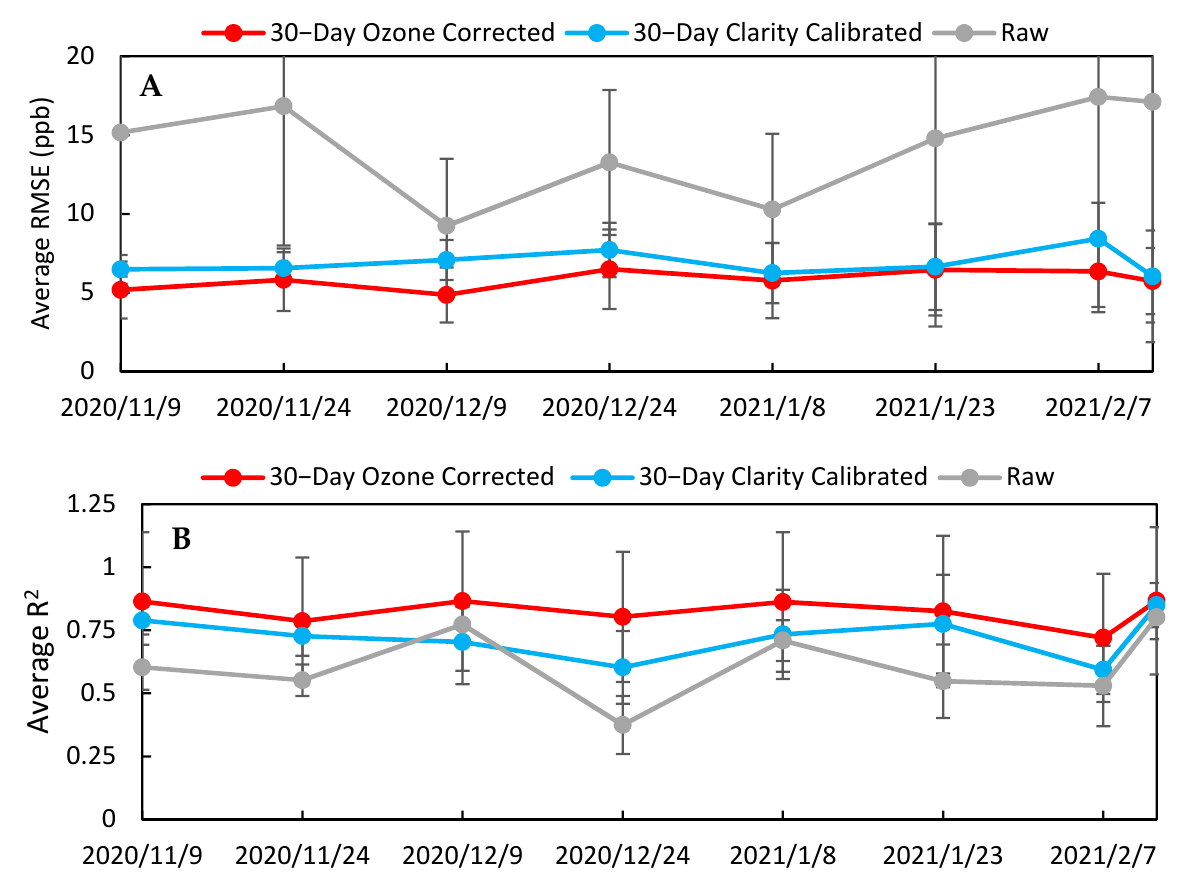
Figure 14. Average RMSE ( A ) and average R 2 ( B ) between the 8 sensors evaluated biweekly for the whole deployment period for raw NO 2 , Clarity 30-day calibration, and Ozone corrected 30-day calibration.